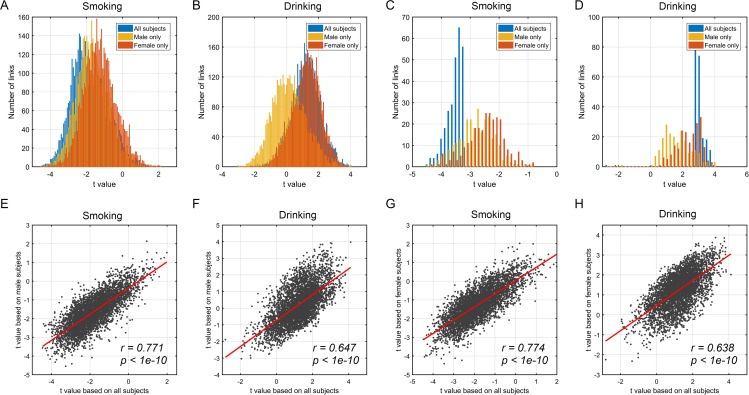
Comparison of whole brain functional connectivity difference patterns between male and female groups.(A, B) show the distribution of t values of the whole brain links for three different groups: all participants, male, and female participants. (C, D) show the distribution of t values of the significantly different links for three different groups. (E, F) show the correlation between the t value of the whole brain links based on all participants and male participants. (G, H) show the correlation between the t value of the whole brain links based on all participants and female participants. For smoking, the distribution for all participants was close to that of the male FC distribution, and more males than females were smokers. For drinking, there was a larger FC difference in females than males, and this is reflected in the closeness of the distribution for all participants to that of females.